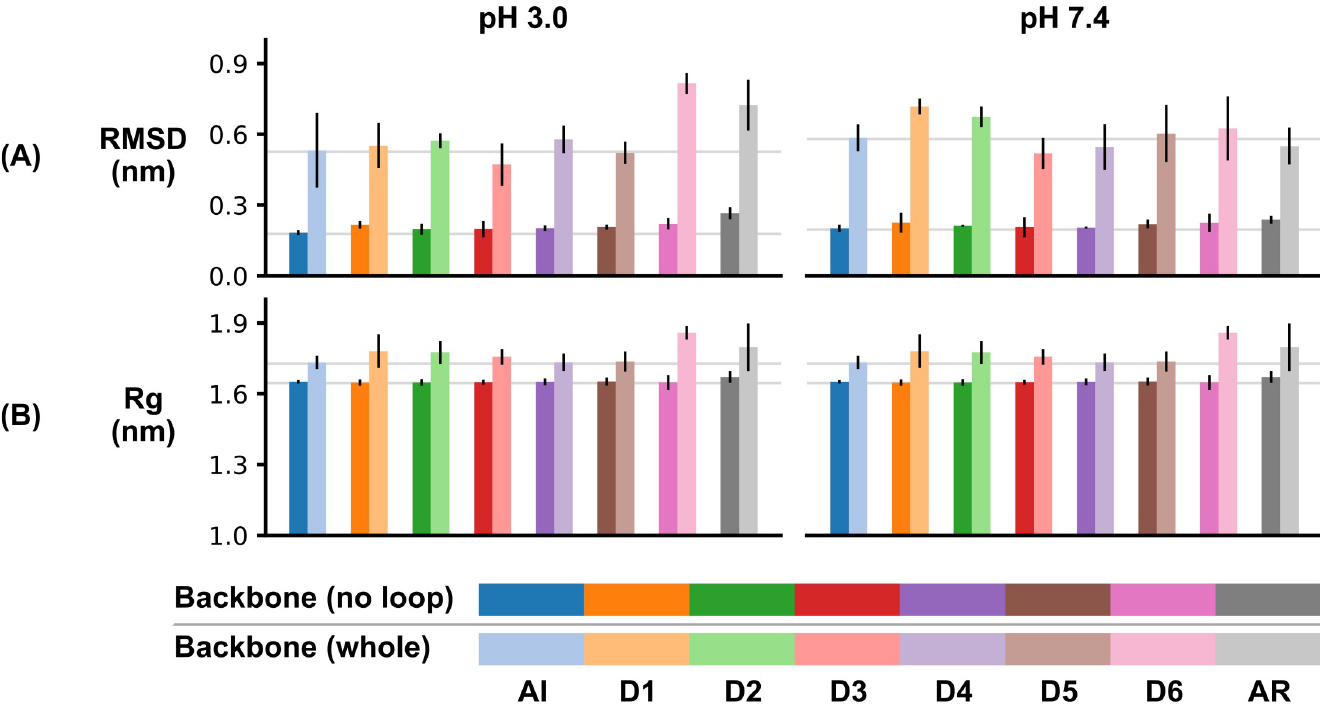
Fig 4. Structural calculations over the last 10 ns of simulations. RMSD (A) and R g (B) of the St PSI dimer at pH 3.0 (left) and 7.4 (right). Data presented are the average ± standard error of the mean ( n = 3). To enable easier parsing of the results, two grey lines have been plotted, both using the AI values for reference. The higher line is plotted at the height of the AI “whole” calculation, and the lower line is plotted at the height of the AI “no-loop” calculation.